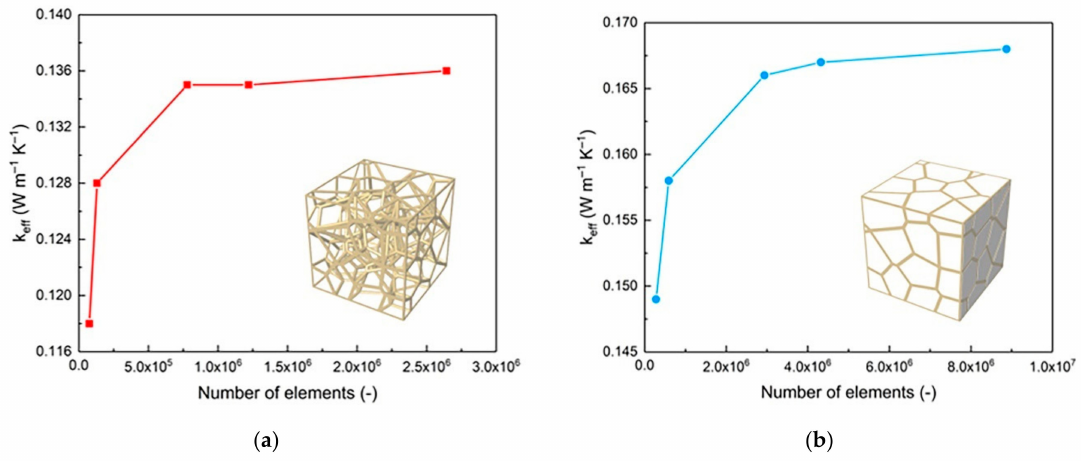
Figure 6. Mesh independence tests based on effective thermal conductivity: ( a ) Vacuum; ( b ) Air-saturated.